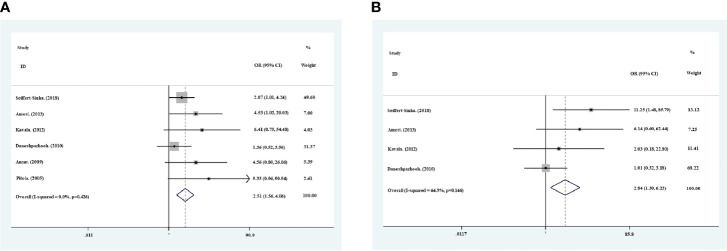
Meta−analysis using the fixed−effects model showed risk ratio of the prevalence of positive anti-TPO antibodies (A) and anti-Tg antibodies (B) in pemphigus patients compared with healthy controls.